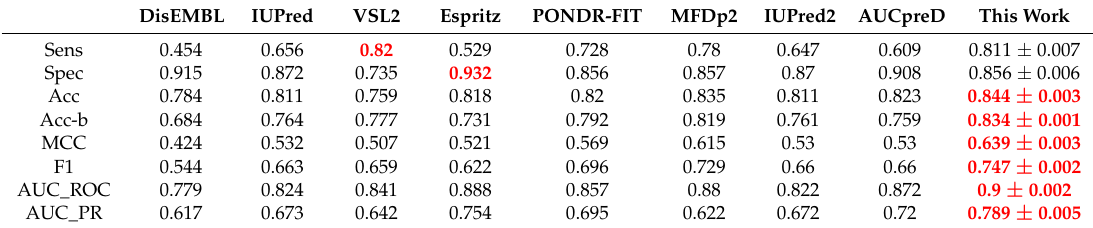
Table 2. Prediction performance of all nine predictors in the independent dataset.